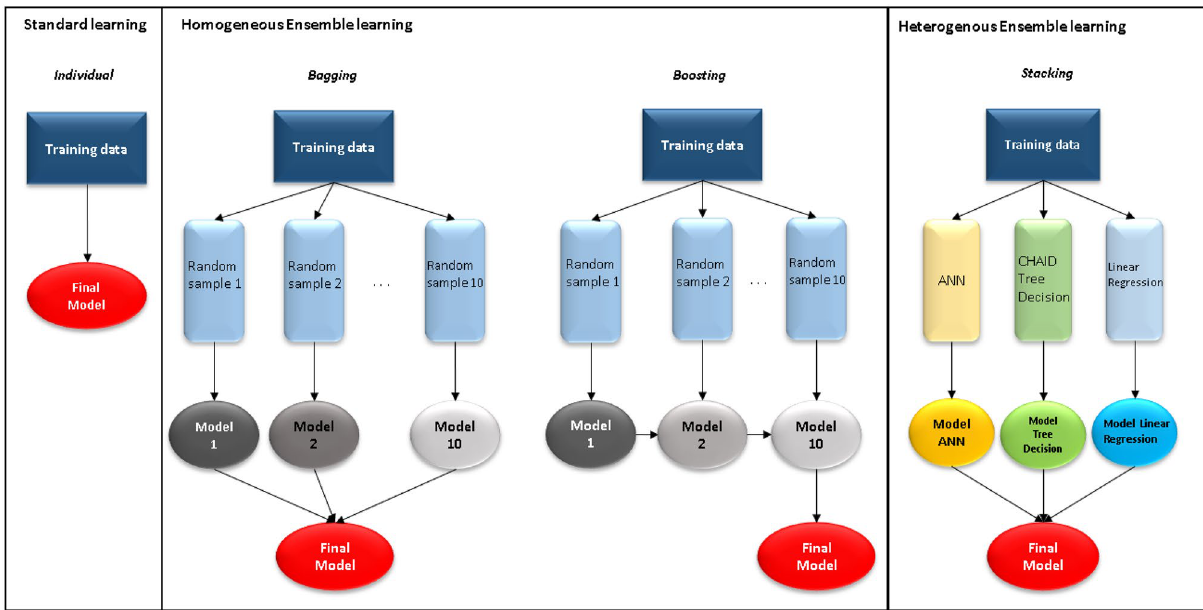
Figure 3. The architecture of standard learning, homogeneous ensemble learning, heterogeneous ensemble